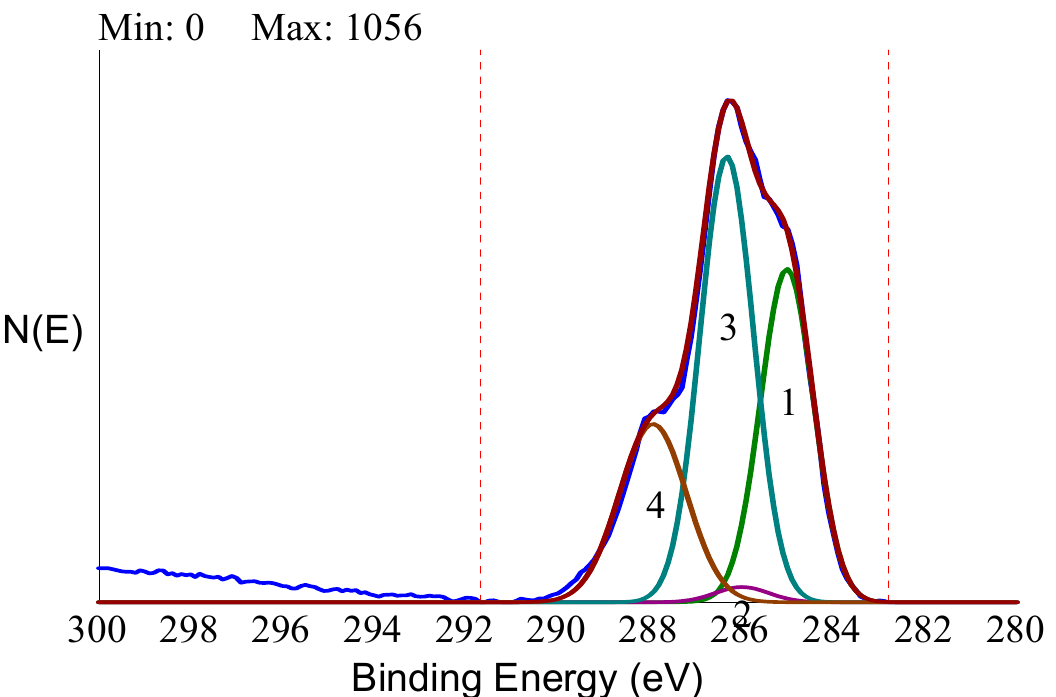
Figure 7. Curve fitting of high-resolution C1s peak of the HY-coated titanium implant by the four components expected from the molecular structure of hyaluronan.